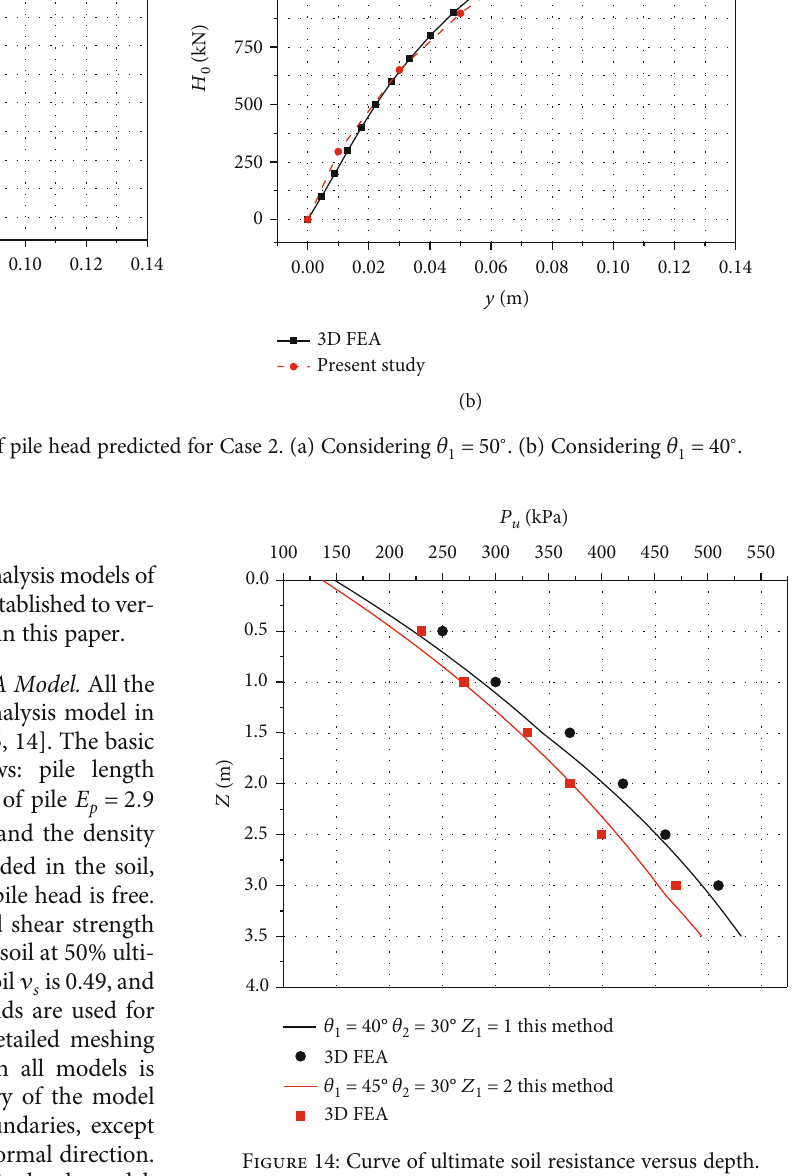
Figure 14: Curve of ultimate soil resistance versus